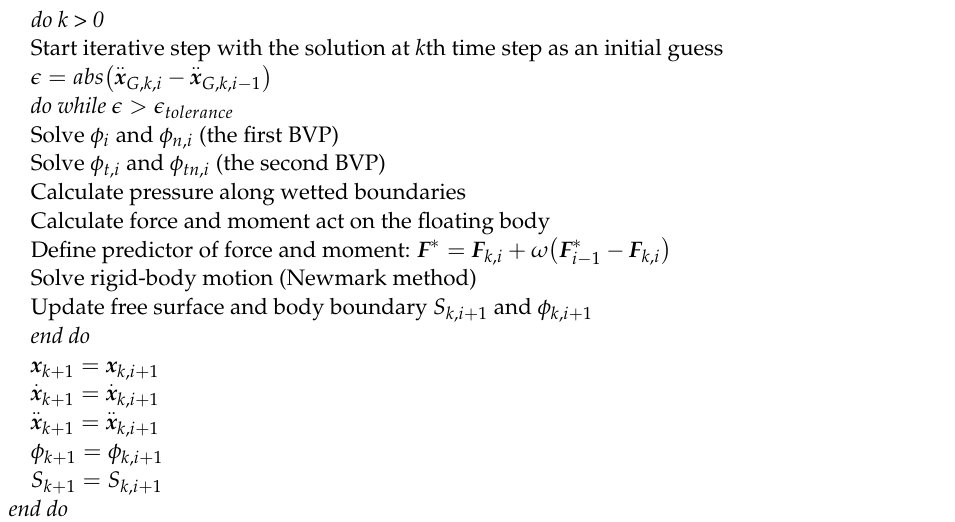
Algorithm 1: An iterative algorithm for FSI by EL